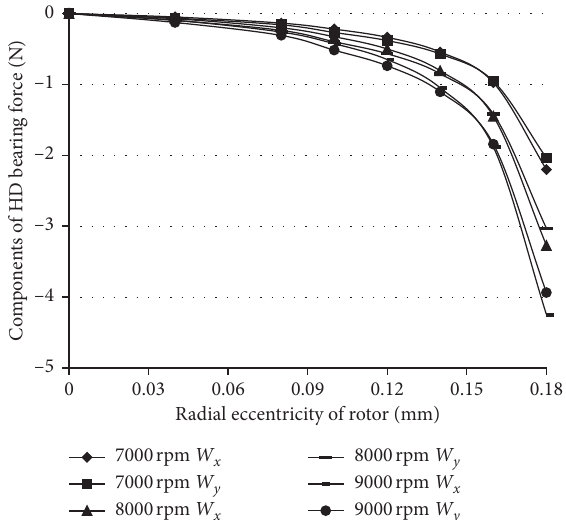
Figure 10: Components of HD bearing force in different speeds and radial eccentricity of the rotor.